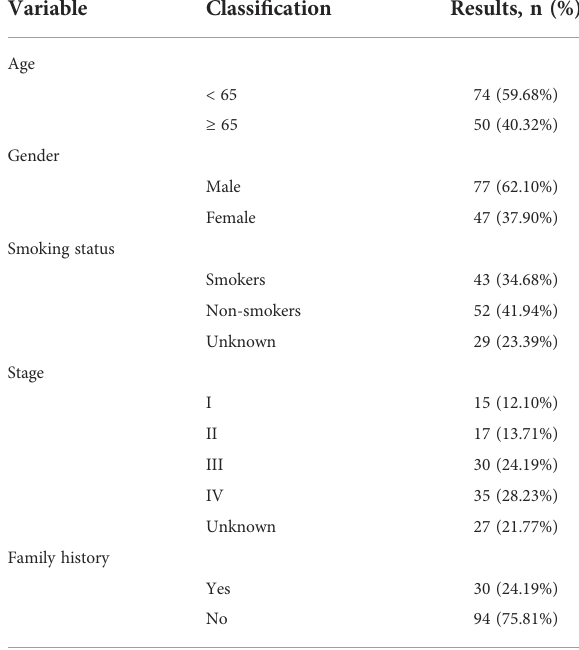
TABLE 1 Patients ’ clinicopathologic